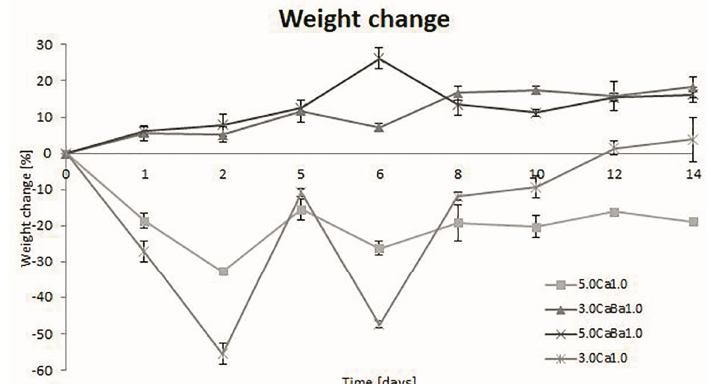
Figure 3. Assessment of wet mass change of hydrogel materials based on sodium alginate crosslinked with Ca 2+ cations and a Ca 2+ /Ba 2+ mixture during continuous immersion in an artificial urine solution after pre-draining in a laboratory filter for 15 s.